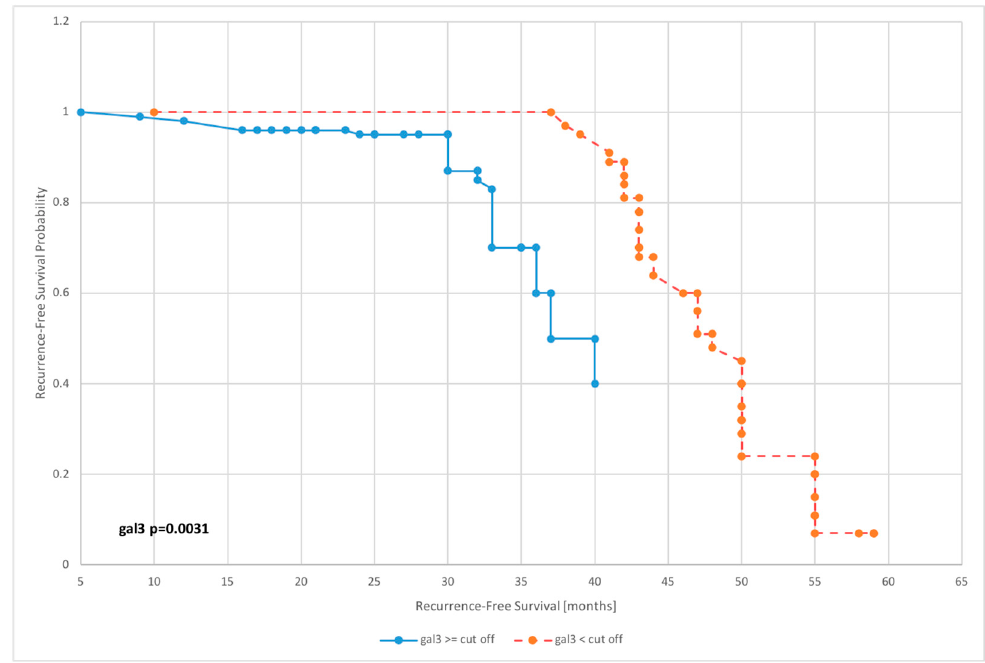
Figure 3. Kaplan–Meier recurrence-free survival curves for endometrial cancer patients based on serum galectin 3 level for cutoff. Diagnostics 2020 , 10 , x FOR PEER REVIEW